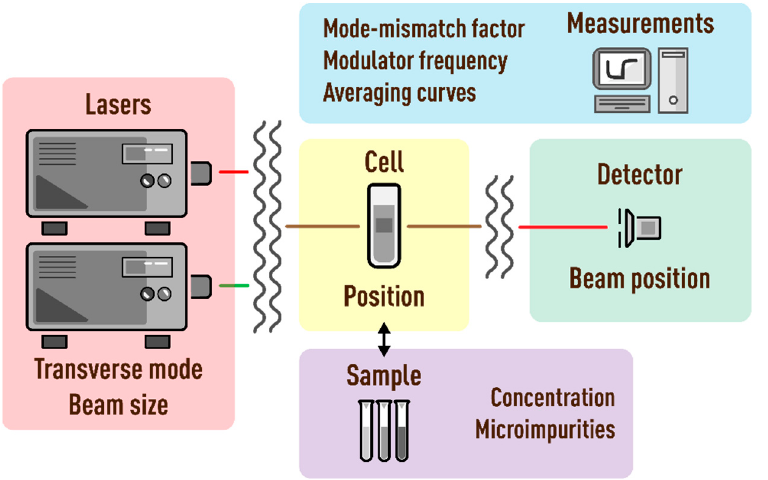
Figure 3. Main groups of factors affecting the systematic error in determination of thermophysical parameters by thermal-lens spectrometry.